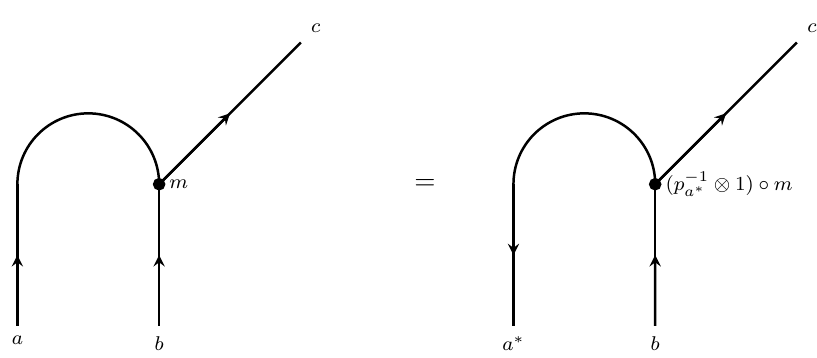
and the fold on the right is a (cid:10) 1) (cid:14) m on the right a (cid:3)